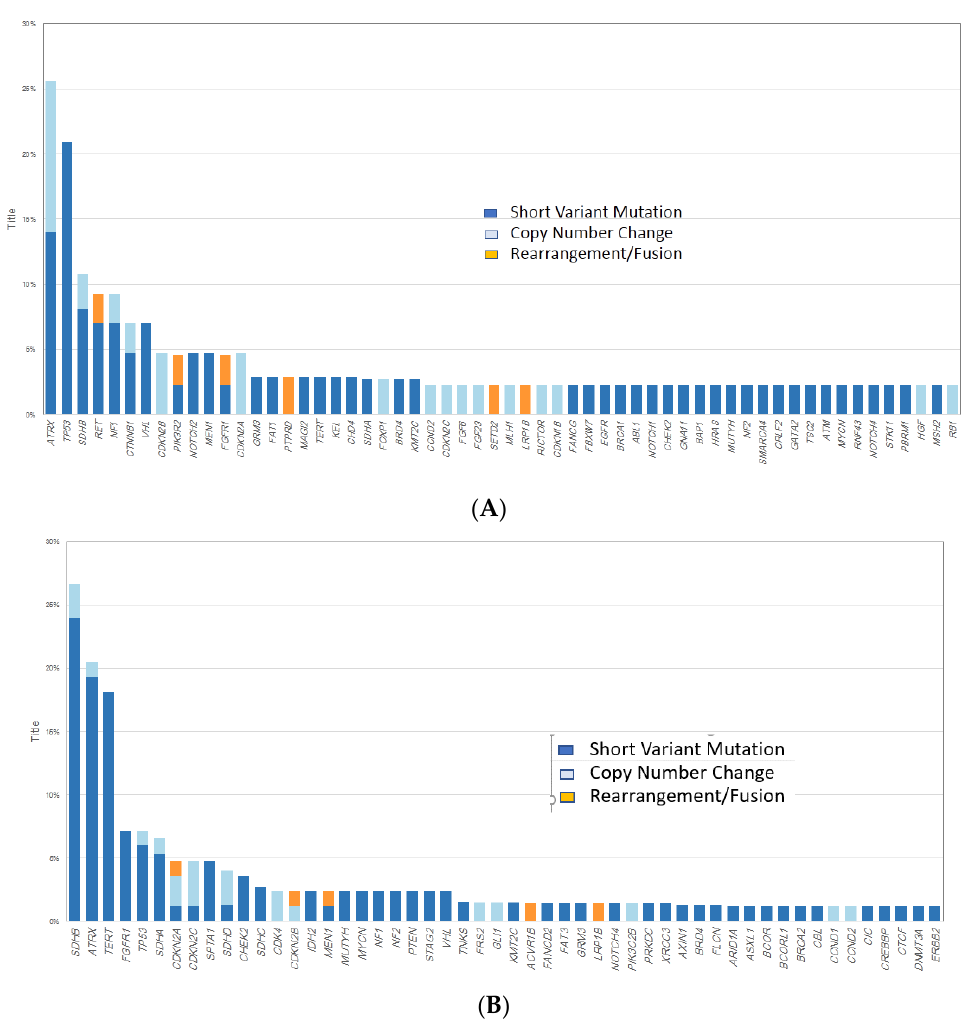
Figure 2. Longtail plots of the frequencies of genomic alterations in CA-Pheo ( A ) and CA-Para ( B ) tumor samples.